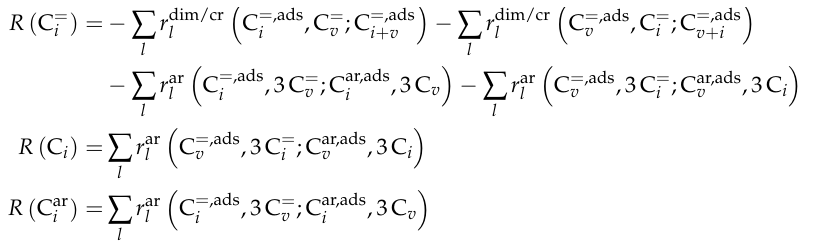
Scheme 12. Net rates of production of the different lumps for the model by Oliveira et al. [237] with i ranging from 2 to 8 for R rules as in Scheme 11 apply for the different indices of the reaction